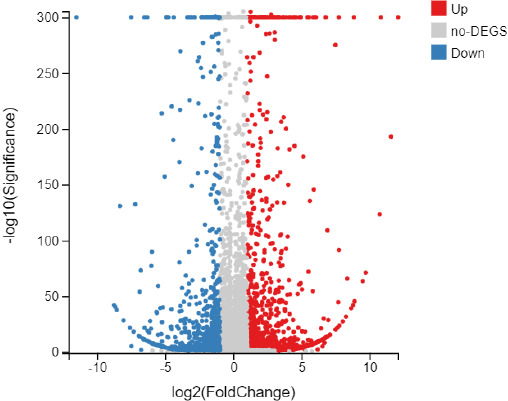
Figure 3. DEGs in F A W A versus F E W E . A volcano plot of DEGs obtained from different comparative analyses. DEGs upregulated in the FAW are represented by red dots, and those that were downregu- lated are represented by blue dots; genes with no significant differences in expression are represented in